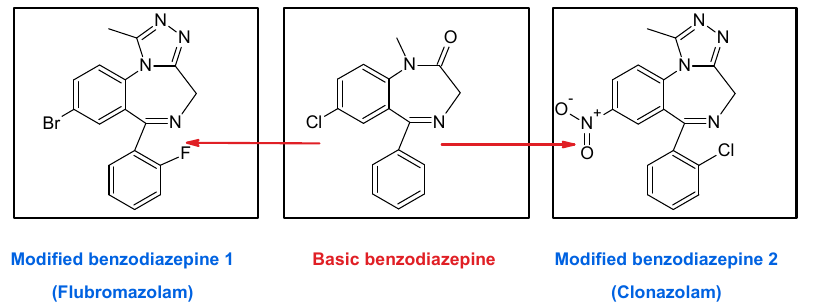
Figure 9. Representation of the modification of basic benzodiazepines to obtain new types of ben- zodiazepines.